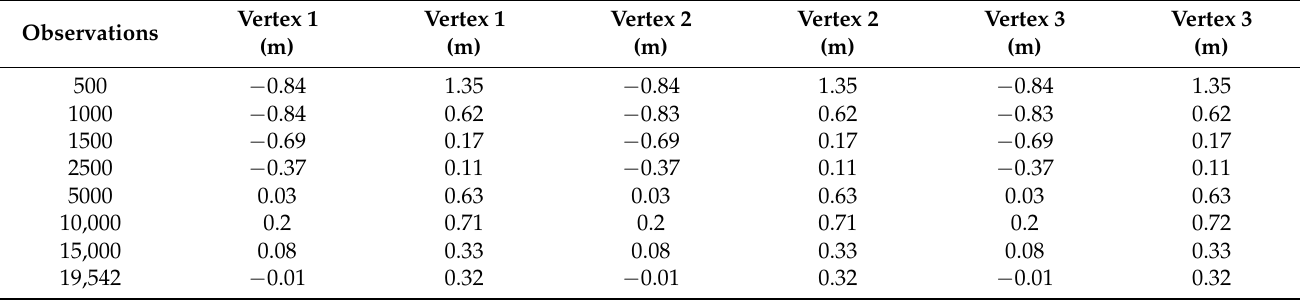
Table A7. The d E , d N error from the E, N coordinates obtained from the expression (27) number of